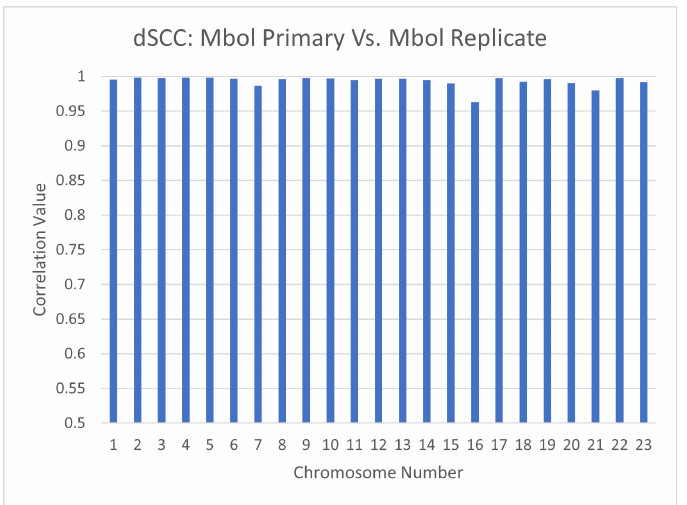
Figure 13. dSCC computed between the outputs of CBCR from the primary and replicate mappings with the Mbol restriction enzyme at 1mb